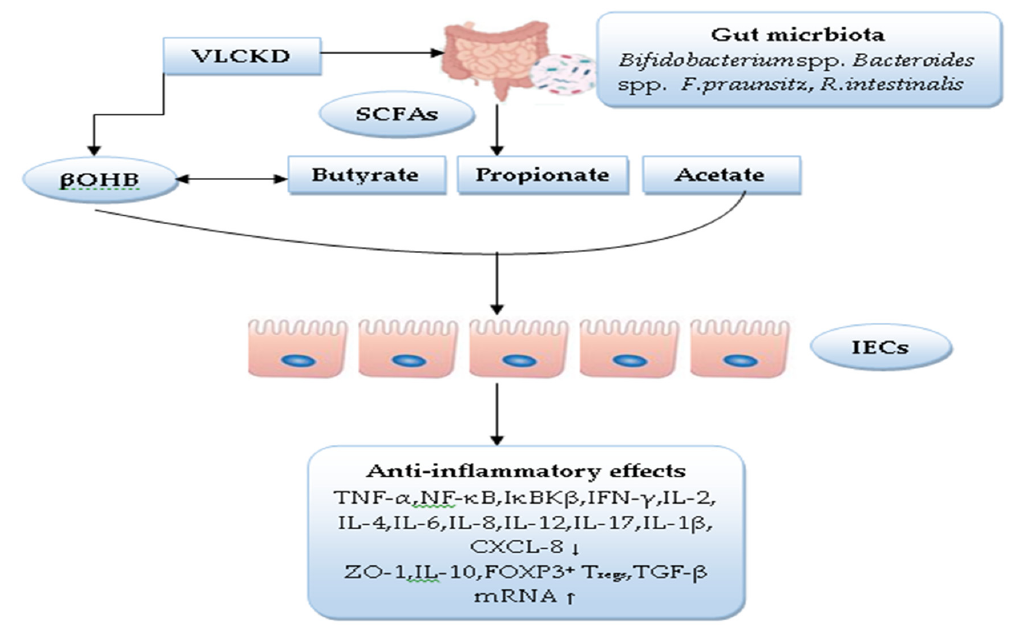
Figure 1. Role of SCFAs as a mediator in paediatric IBD therapy. ( ↓ ) decrease, ( ↑ )